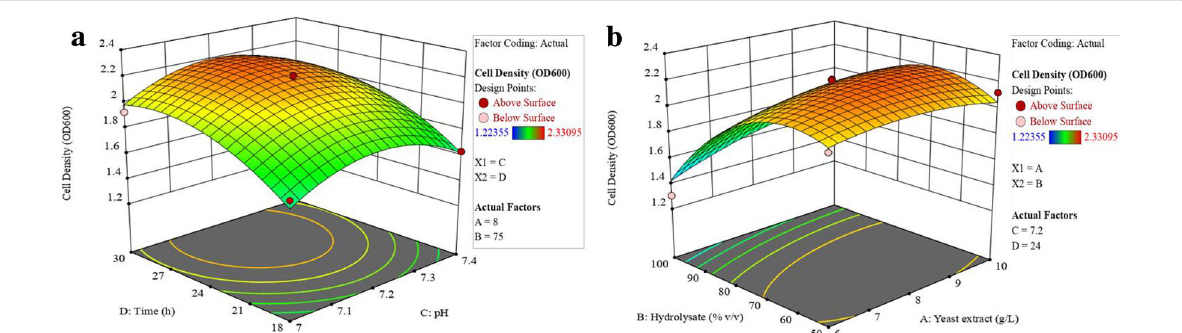
Fig. 2 Three-dimensional (3D) response surface generated by the model for the independent variables that affect the yield of biomass; time and pH ( a ) and concentration of hydrolyzate and yeast extract ( b